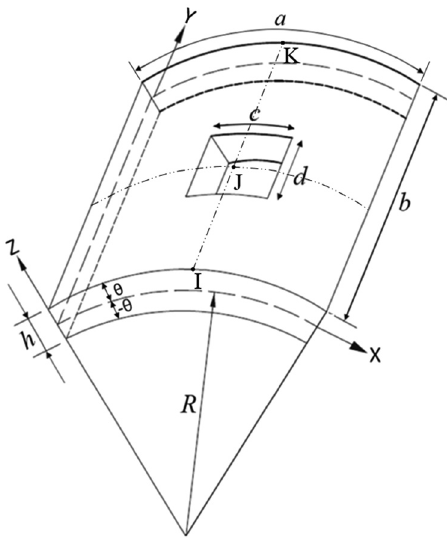
Figure 2: Laminated composite cylindrical panel with a central cutout [ 16 ]